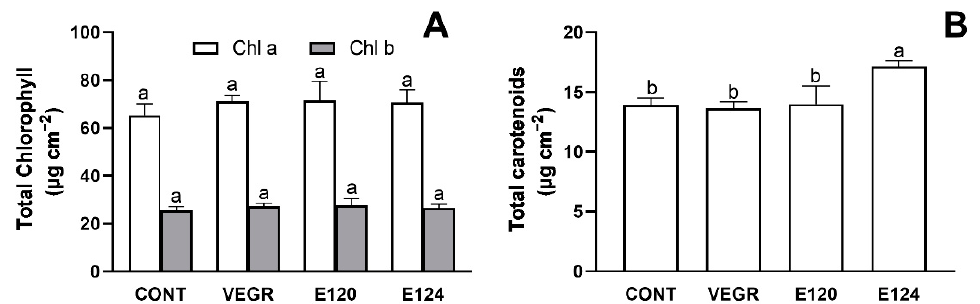
Figure 2. Concentration of chlorophyll a (Chl a) and b (Chl b) ( A ) and total carotenoids ( B ) in C. sativus control seedlings (CONT) and seedlings treated with different food dyes (VEGR, E120, and E124). Values are means ± SEM ( n = 10). Different letters indicate statistically significant differences among treatments. Table 1. Total fresh biomass and maximal PSII photochemical efficiency (F v /F m ) in C. sativus control seedlings (CONT) and seedlings treated with different food dyes (VEGR, E120, E124). Values are means ± SEM ( n = 20). Different letters indicate statistically significant differences among treatments. CONT VEGR E120 E124 Total biomass